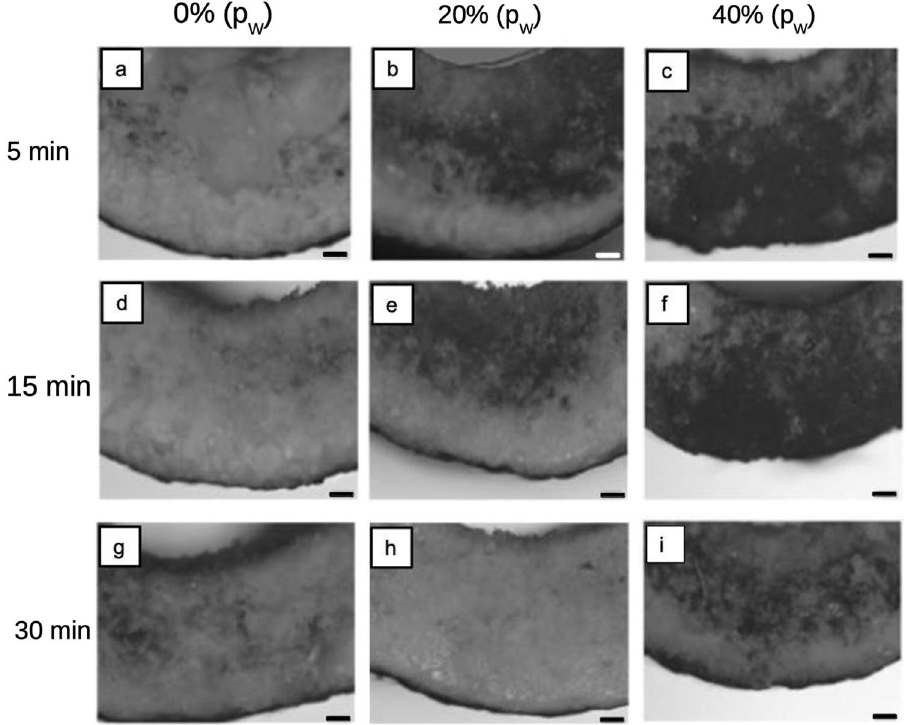
Fig. 2 Stress – strain curves of the PLGA/PVA scaffolds were derived from compression testing. These were obtained for p W = 0, 20, and 40% at t = 30 min. The region between points a to b indicates the region of initial loading. The region between points b to c indicates a characteristic plateau, suggesting possible collapse of the engineered holes in the scaffold (Fig. 1A). The region between points c to d accounts for the mechanical support provided by the PLGA-based material to resist the load. Point e indicates the point of